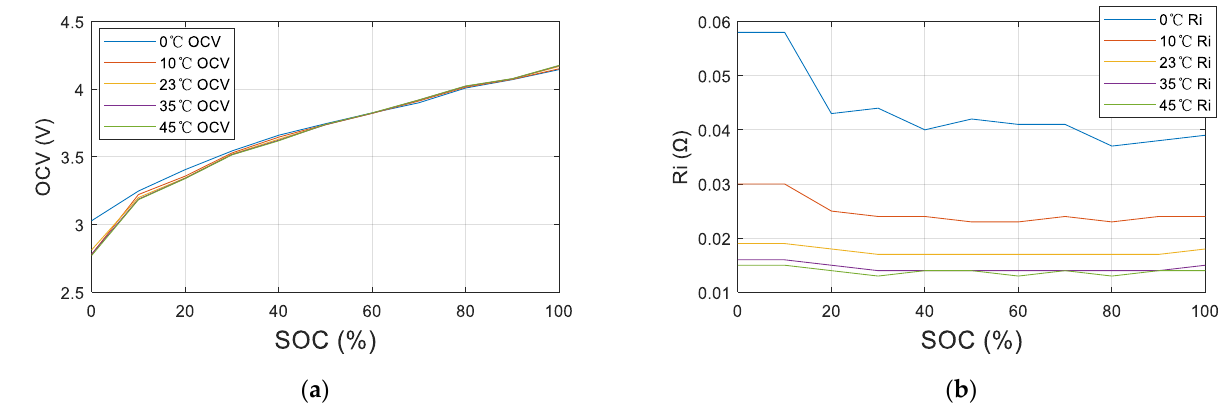
Figure 12. ECM parameter derivation result by varying SOC temperatures: ( a ) SOC-OCV; ( b ) SOC-R i .